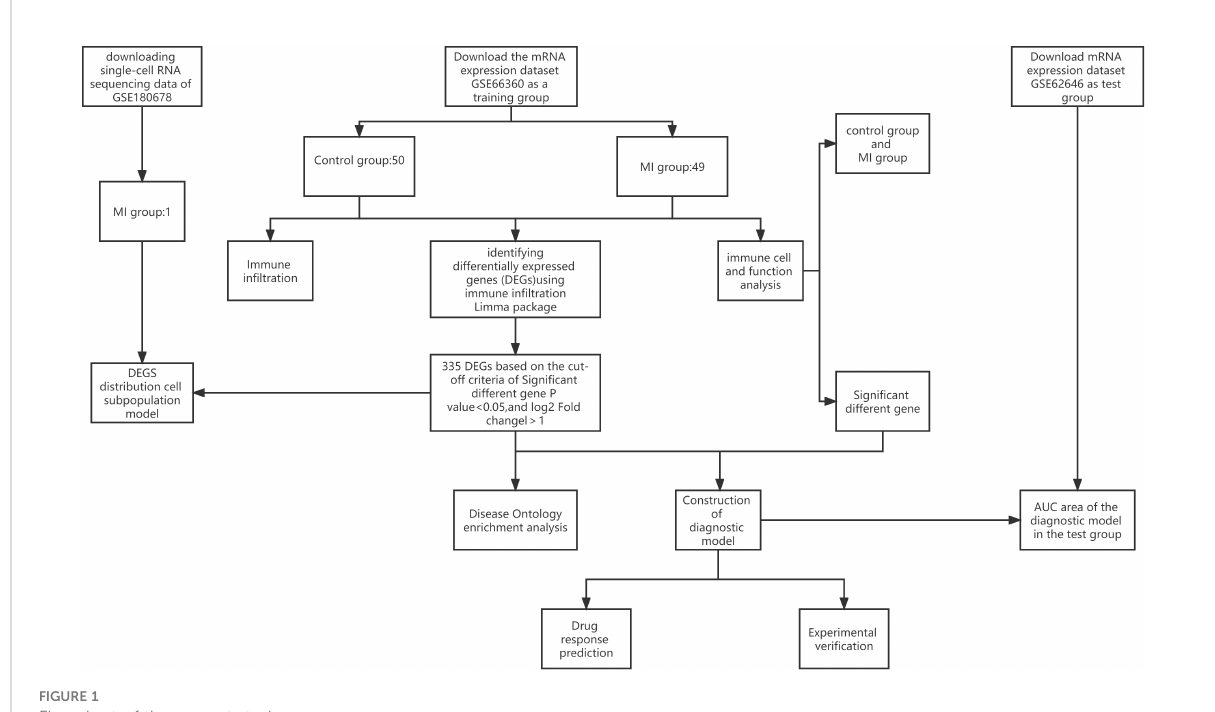
FIGURE 1 Flowchart of the current